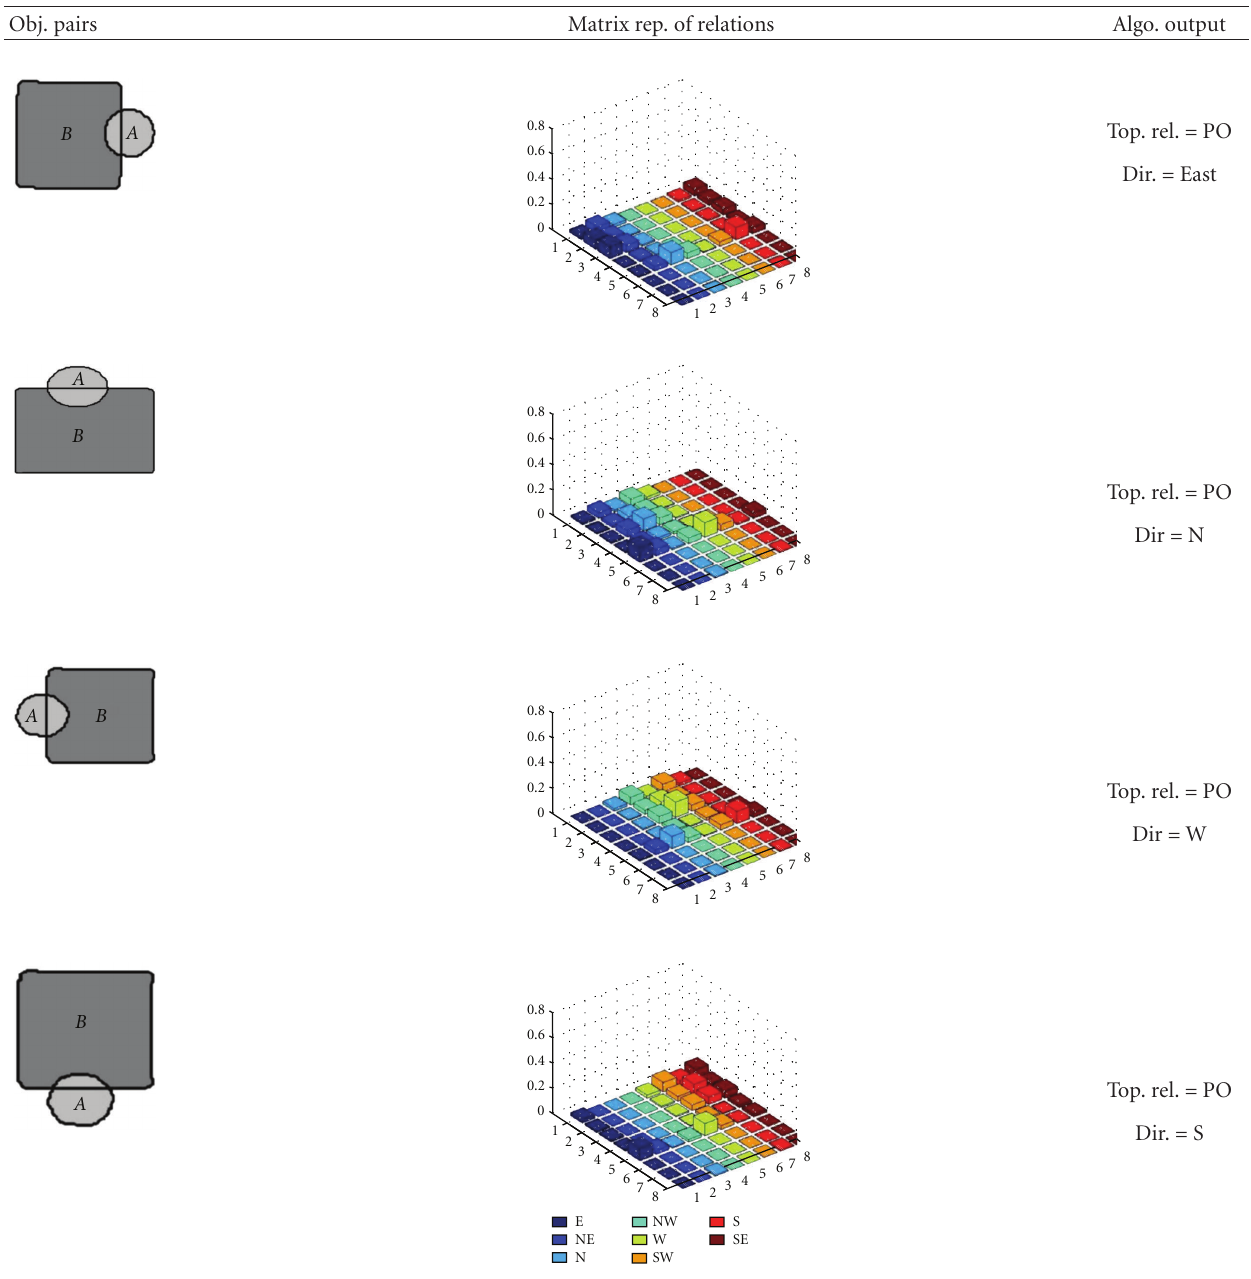
Table 4: Object pairs with PO topological relation. Obj. pairs Matrix rep. of relations Algo. output